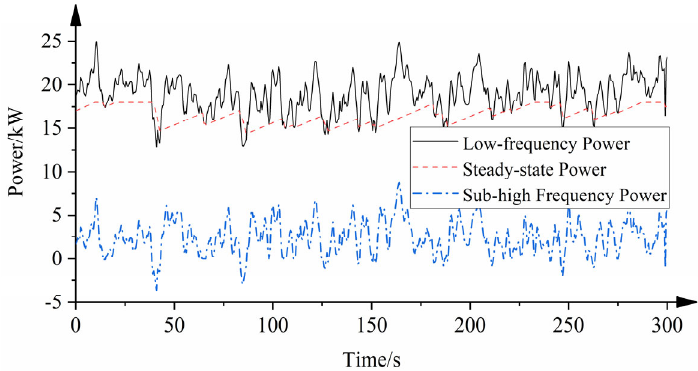
Figure 16. Second − layer decoupling results based on the logic rules.